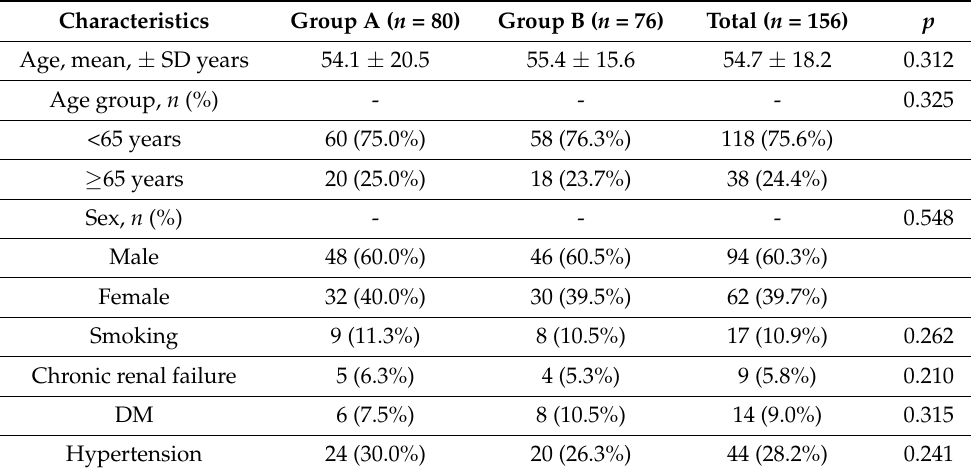
Table 1. Demographics of patients with pilon and distal fibula